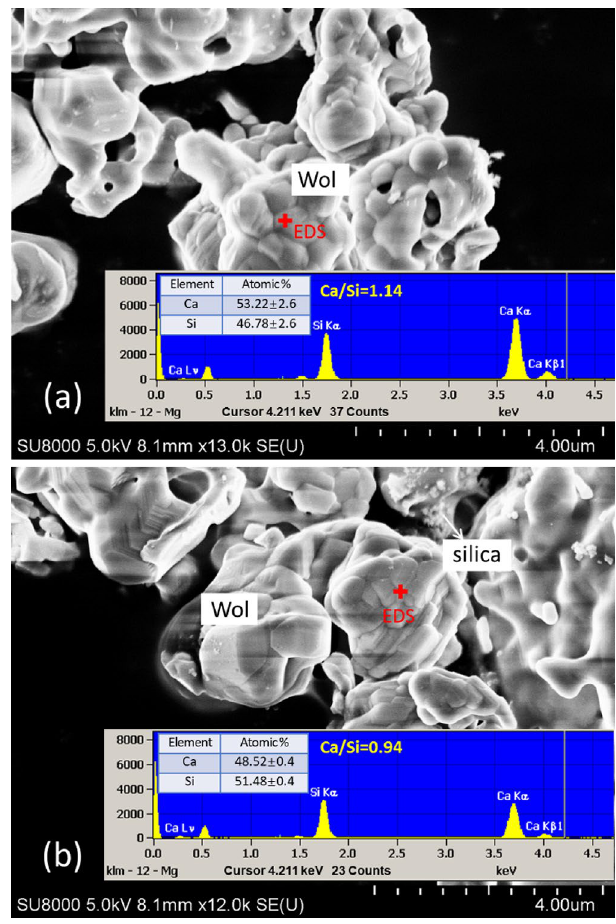
Figure 3. SEM images and EDS results of calcium silicate particles ( a ) before and ( b ) after 20 min treatment with 0.3 M GLDA. Wol: wollastonite.